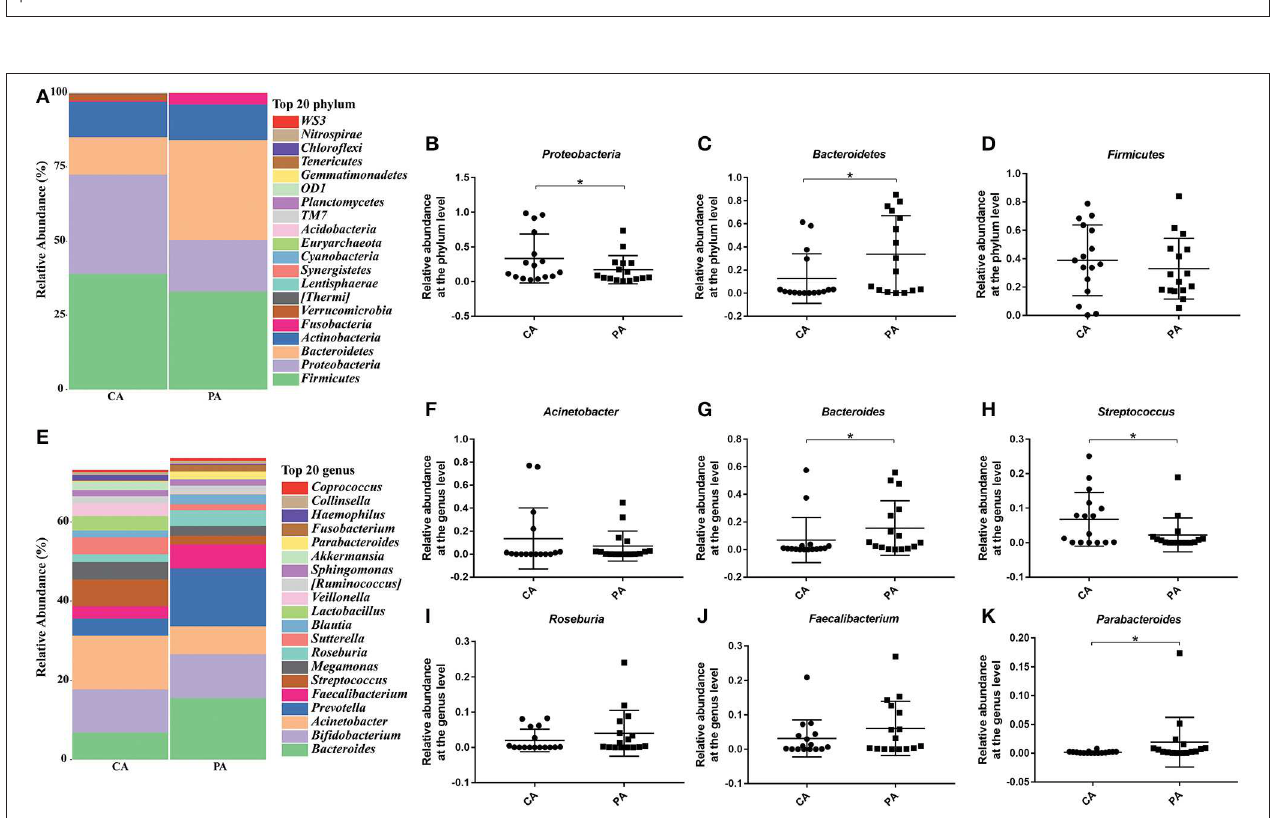
FIGURE 6 | Effect of probiotics on microbial composition between groups CA and PA at phylum and genus levels. (A) , the relative abundance of intestinal microbiota at the phylum level; (B) , Proteobacteria ; (C) , Bacteroidetes ; (D) , Firmicutes . (E) , the relative abundance of intestinal microbiota at the genus level; (F) , Acinetobacter ; (G) , Bacteroides ; (H) , Streptococcus ; (I) , Roseburia ; (J) , Faecalibacterium ; (K) , Parabacteroides . CA, control group 5–7 days after bowel preparation ( n = 16); PA, probiotic group 5–7 days after bowel preparation (Supplement the Bifidobacterium Tetragenous viable Bacteria Tablets after colonoscopy for up to 5–7 days, three tablets and three times a day) ( n = 16). Data are presented as means ± SD. * P < 0.05.